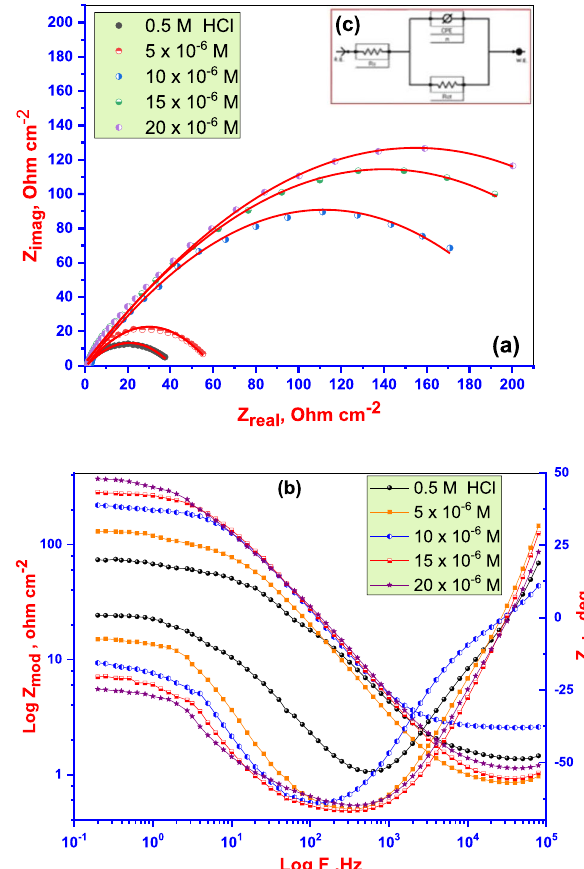
Figure 7. Nyquist plots ( a ), and Bode plots ( b ) for copper in 0.5 M HCl solution with/without of different concentrations of DTG with using a suitable equivalent circuit model ( c ).